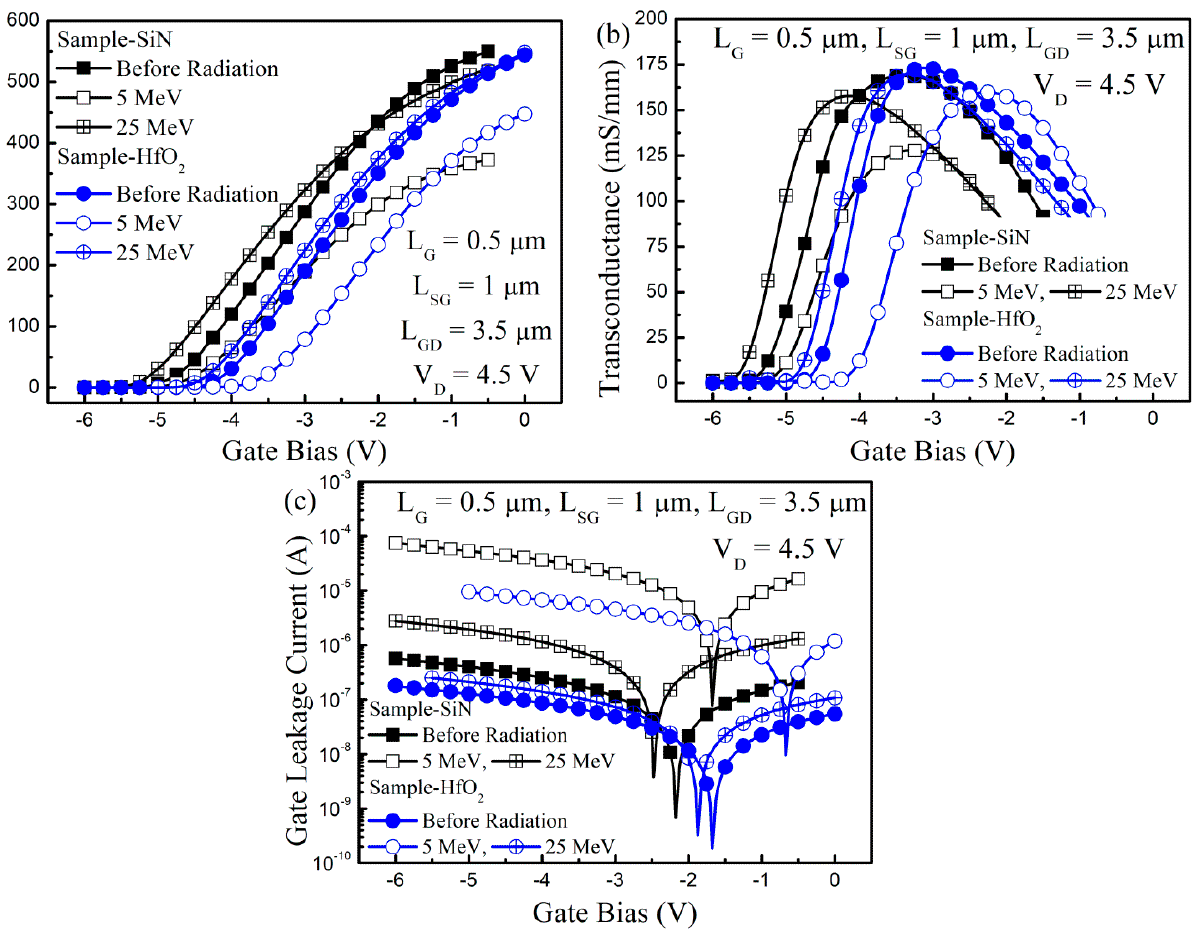
Figure 2. Typical transfer characteristics comparison of GaN-based MIS-HEMTs for the 5 nm-thick Si 3 N 4 and HfO 2 gate insulator before and after proton irradiation at 5 and 25 MeV. ( a ) Drain current; ( b ) transconductance; ( c ) gate leakage current versus gate bias.